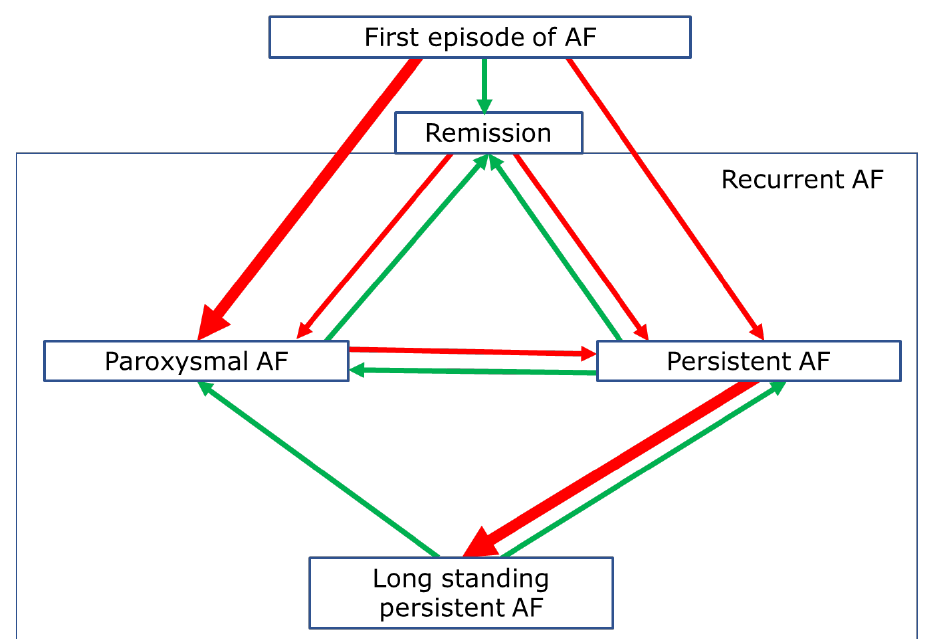
Figure 1. Classification of atrial fibrillation based on its temporal pattern. Red arrows indicate deterioration, green arrows indicate improvement. The width of the arrows represents the most common clinical course. After a first episode, AF commonly becomes paroxysmal. Remission or primary persistent AF may occasionally occur. Paroxysmal AF may remain paroxysmal, go into remission, or progress into persistent AF. Persistent AF, if not treated effectively, becomes long- standing persistent AF. Without active treatment, persistent or long-standing persistent AF almost never improves to the paroxysmal form or remission.